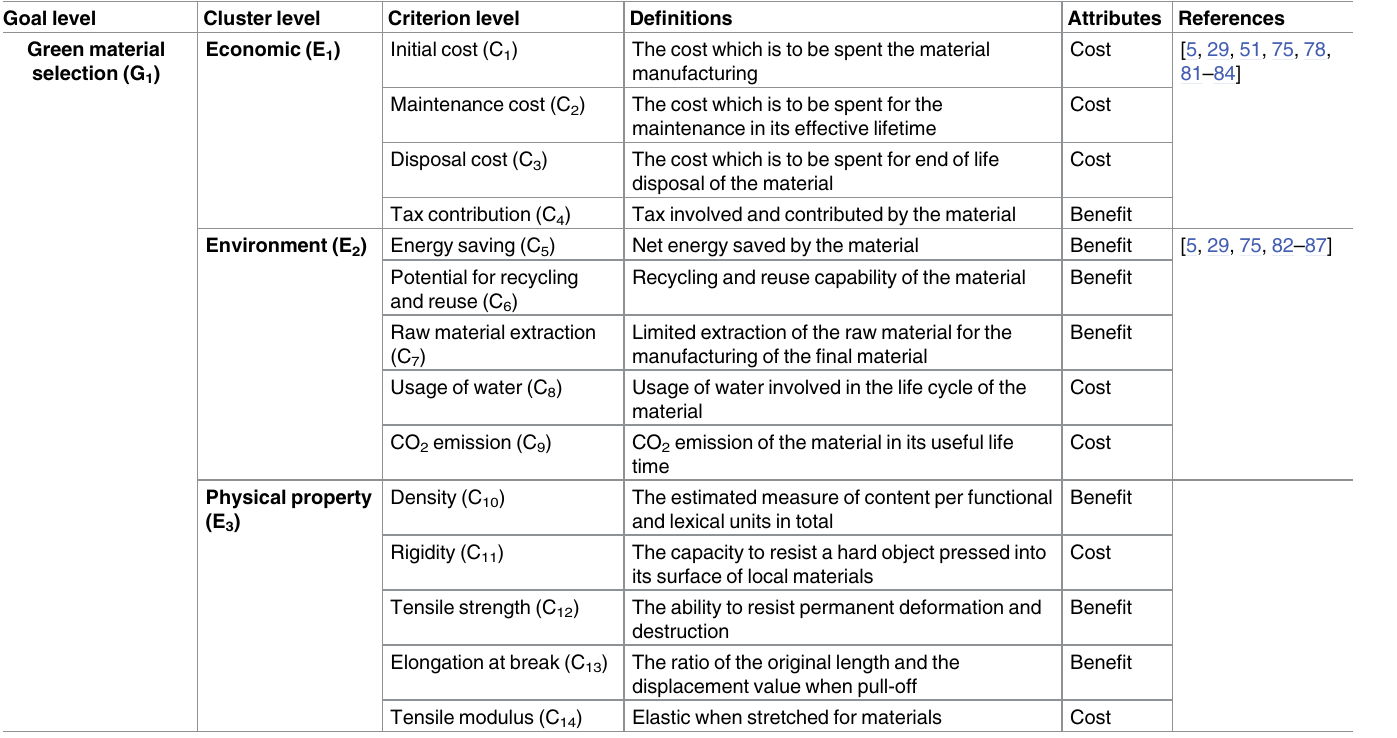
Table 2. Hierarchical structure of criteria for material